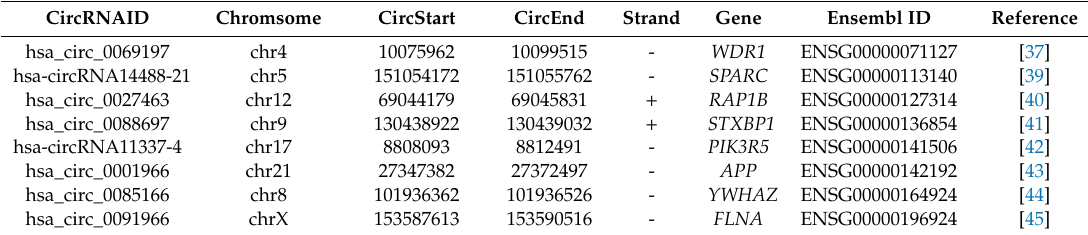
Table 4. Selection of eight significant circRNAs linked to platelet